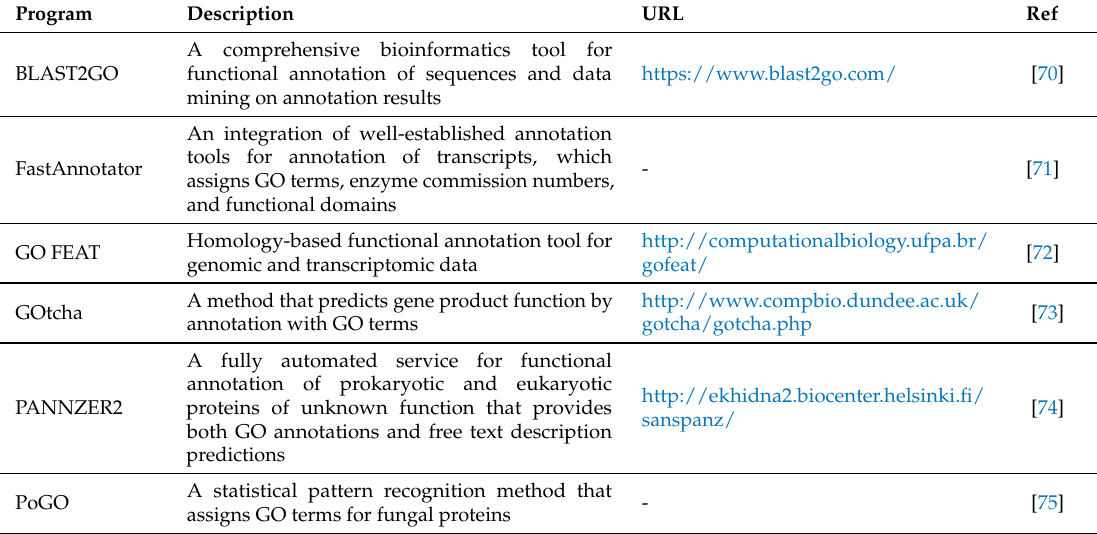
Table 2. Ontology based annotation